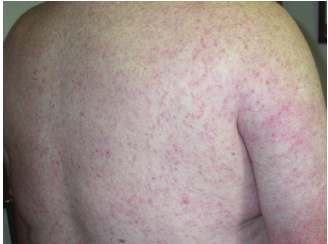
Figure 1. Diffuse maculopapular rash associated with West Nile virus